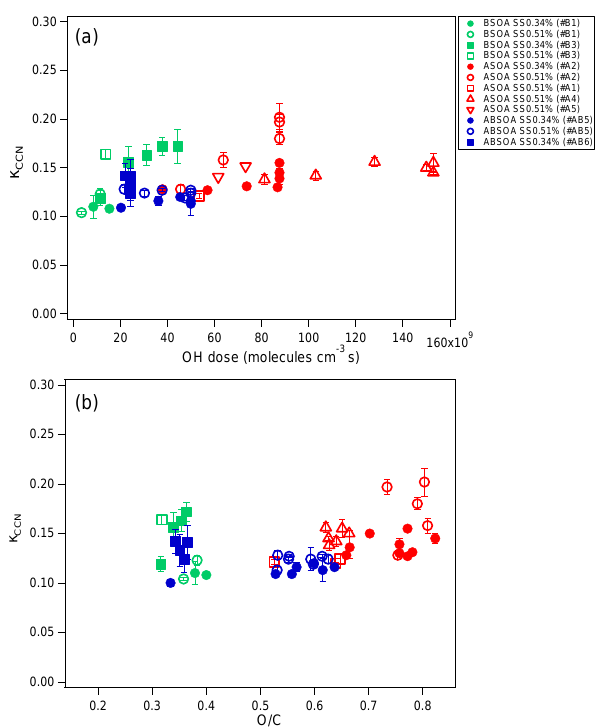
Figure 1. CCN activity of BSOA, ASOA, and ABSOA as a function of OH dose (A) and O/C of aerosol (B). κ CCN at two supersaturations (SS) 0.34% (solid markers) and 0.51% (open markers) is shown. The green, red and blue colors indicate BSOA, ASOA and ABSOA, respectively. κ CCN at similar SS is compared since κ CCN depended on SS. BSOA, ASOA, and ABSOA showed no significant difference at a given SS. Although ASOA had higher degree of oxidation (O/C) than BSOA, ASOA components did not enhance κ CCN